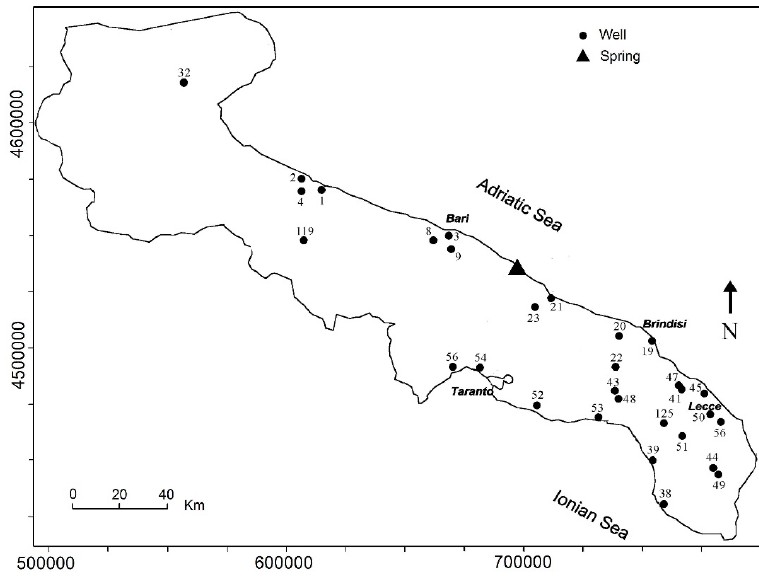
Figure 5. Location map of the selected wells and springs (x and y coordinates were plotted as meters). Table 1. Statistical values of the selected piezometric time series (AC: angular coefficient of straight line